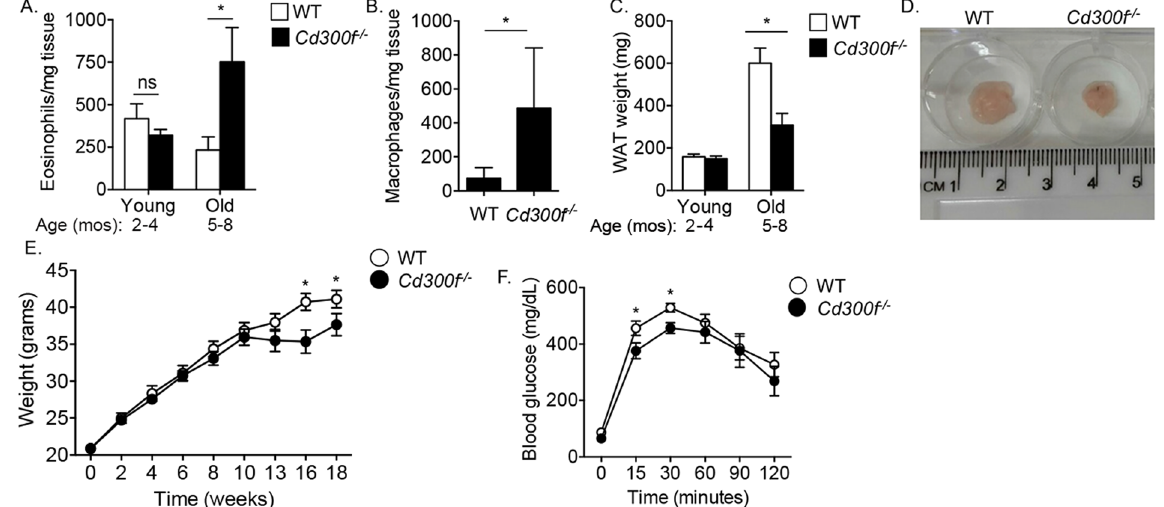
Figure 6. Cd300f − / − mice display age-related accumulation of eosinophils and macrophages and decreased adipose tissue weight. White adipose tissue (WAT) of young (2–4 months) and aged (5–8 months) wild type (WT) and Cd300f − / − mice were obtained and total eosinophils ( A ) and macrophages ( B ) per mg tissue were determined. Moreover, the weight of WATs from WT and Cd300f − / − mice was determined ( C ). In ( D ) a representative photograph of WAT size from WT and Cd300f − / − mice is shown. WT and Cd300f − / − mice were fed with high fat diet (HFD) for up to 18 weeks and weighed at the indicated time points ( E ). Following 18 weeks of HFD, mice were tested for glucose tolerance ( F ). Data in ( A – C ) are from n = 3, 2–3 mice per time point; in ( D ) data are representative of on one out of eight; in ( E – F ) data are from n = 3 using 10 mice per group; * p < 0.05, ** p < 0.01, *** p < 0.001 as analyzed by Student’s t-test ( A – C ) and two-way ANOVA followed by Tukey post-hoc test ( E , F